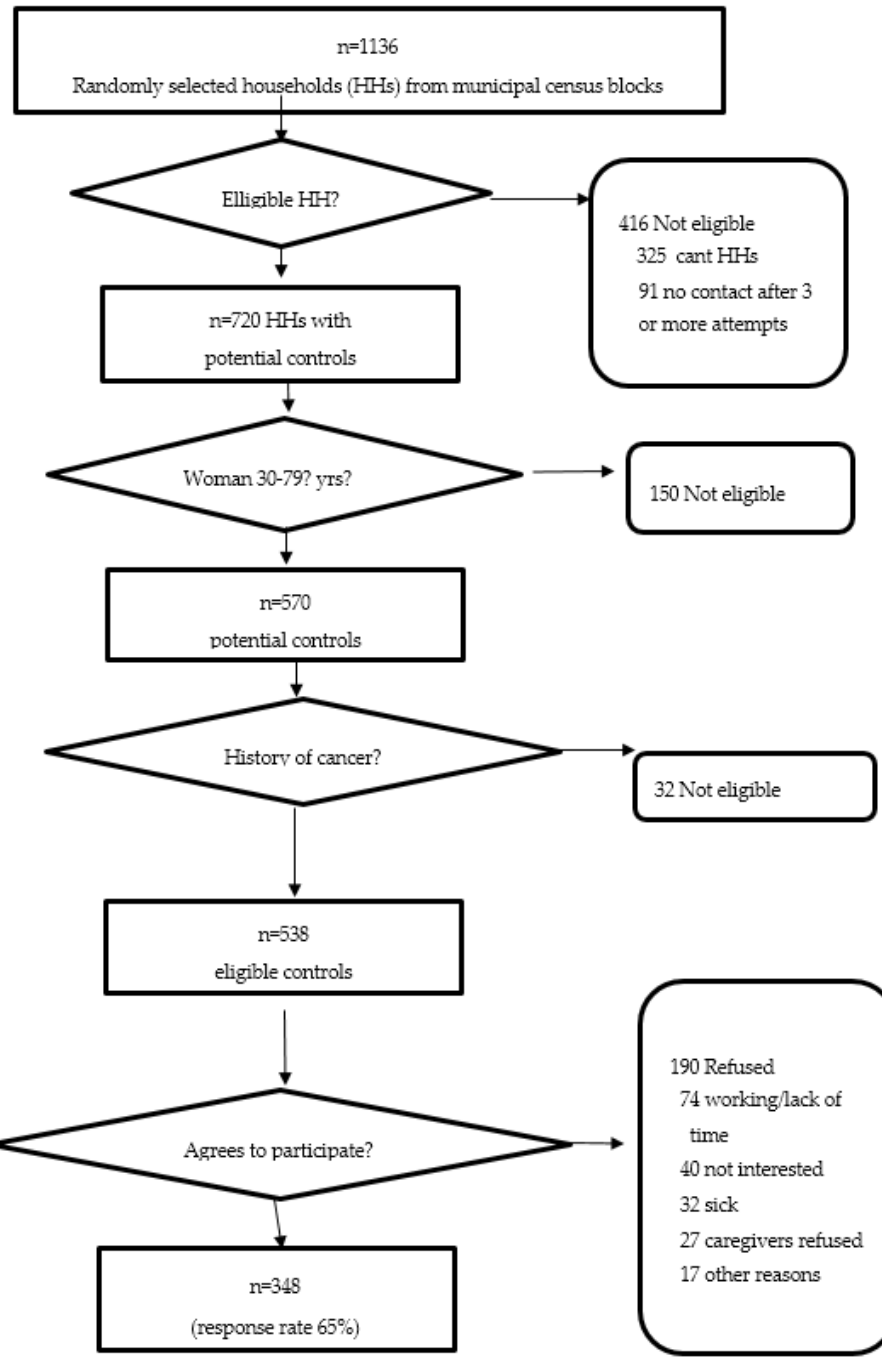
Figure 3. Selection of population-based controls in the Atabey Study, Puerto Rico.